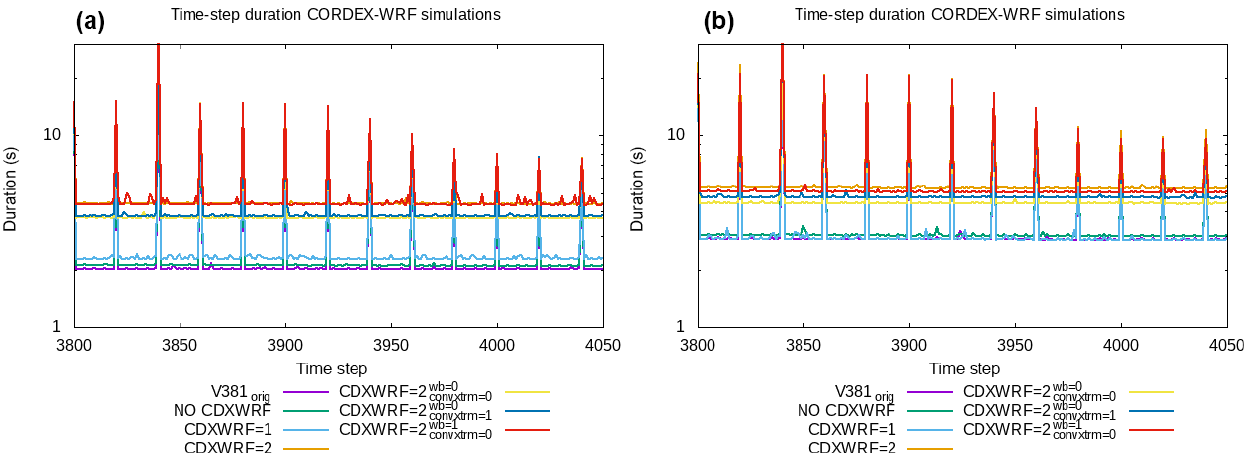
Figure 18. Elapsed times for each individual time-step integration on nested domain d02 (time steps from number 3800, simulating date 1 January 2014 15:35:00UTC, to 4050 for 1 January 2014 16:37:30UTC). Model was run with different module configurations. See text for more details. Larger time steps are related to activation of the shortwave and longwave radiation scheme (every 5min). For WRF compilation using IFORT (a) and GCC compilers (b)